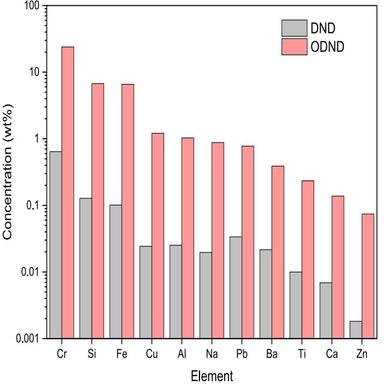
ICP-MS elemental analysis of DND (grey) and ODND (red). The detected elements are as function of their concentration in weight percent. For visibility purposes, a log-scale was used. (For interpretation of the references to colour in this figure legend, the reader is referred to the web version of this article.)